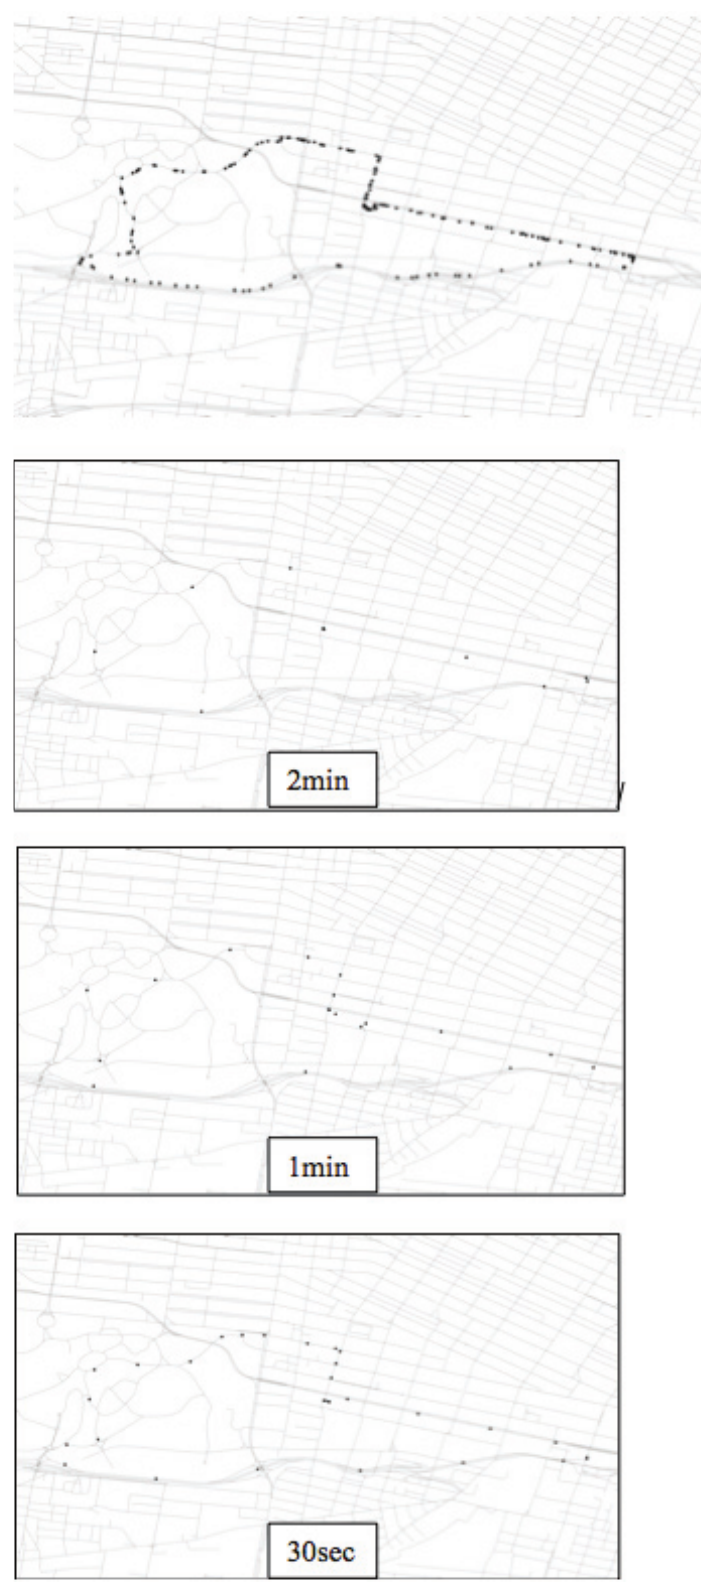
Figure 2. GPS points